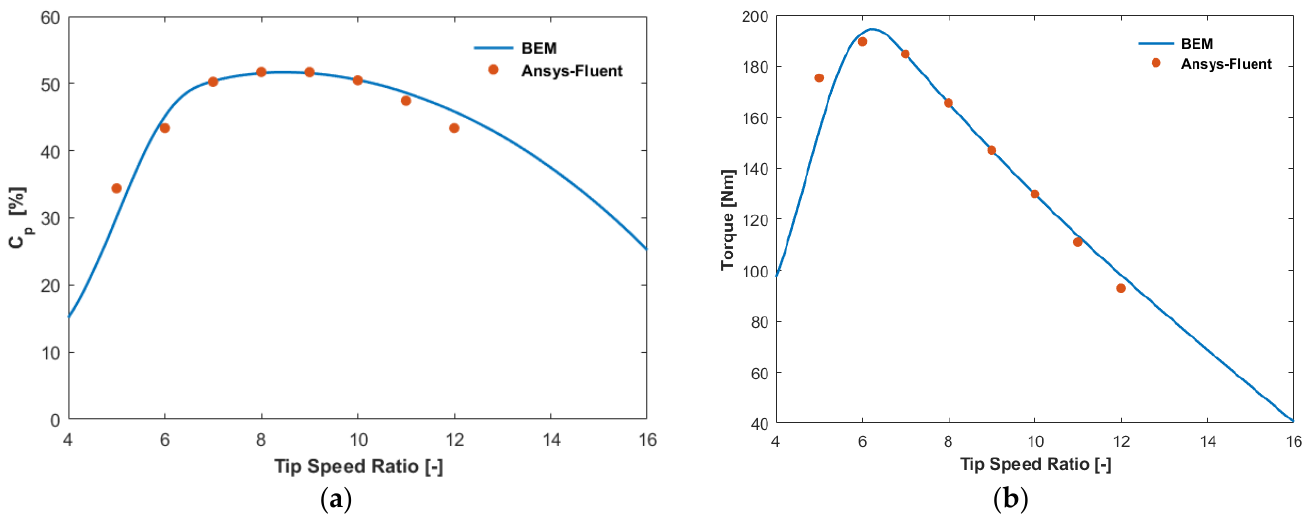
Figure 9. Performance coefficient results at a wind speed of 10 m/s using BEM and Ansys-Fluent simulation. ( a ) Power coefficient vs. tip speed ratio. ( b ) Torque vs. tip speed ratio.